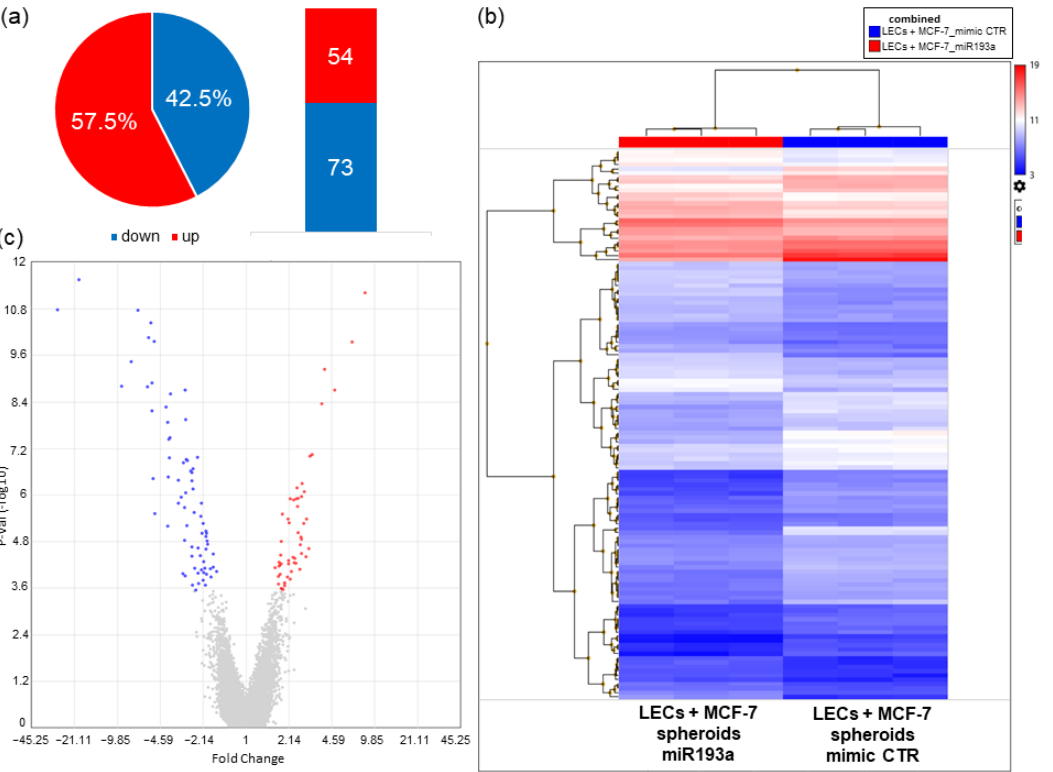
Figure 7. Differentially regulated genes (DRGs) in spheroids transfected with miRNA193a-3p. ( a ) Number of DRGs and a pie chart representation of up and downregulated genes in the per- centage of the total number of DRGs. ( b ) Heatmap representation of DRGs in a spheroid formed by LEC + MCF-7 cells transfected with 25 nM of the mimic control and miR193a. ( c ) Volcano plot showing the most upregulated genes (red), the most downregulated genes (blue), and the most statistically significant genes are toward the top. The Transcriptome Analysis Console (TAC, Applied Biosystems) was used for analyzing gene expression